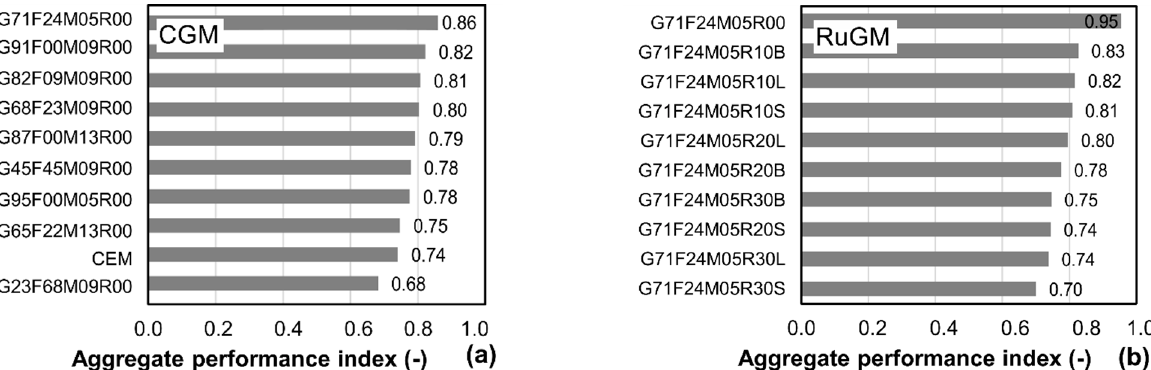
Figure 8. Aggregate performance index for: ( a ) CGM, ( b ) RuGM.